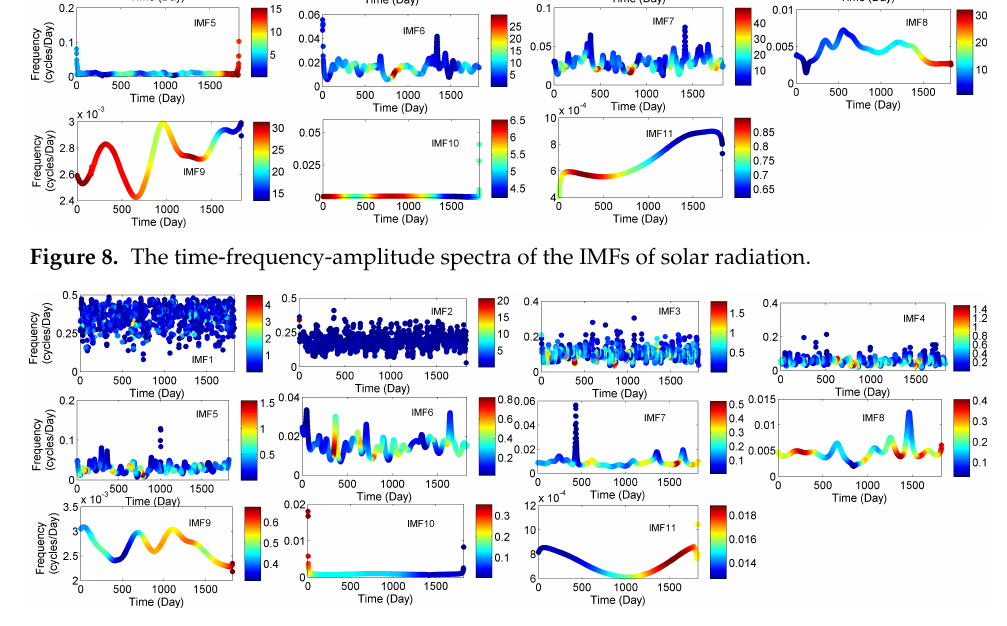
Figure 9. The time-frequency-amplitude spectra of the IMFs of wind